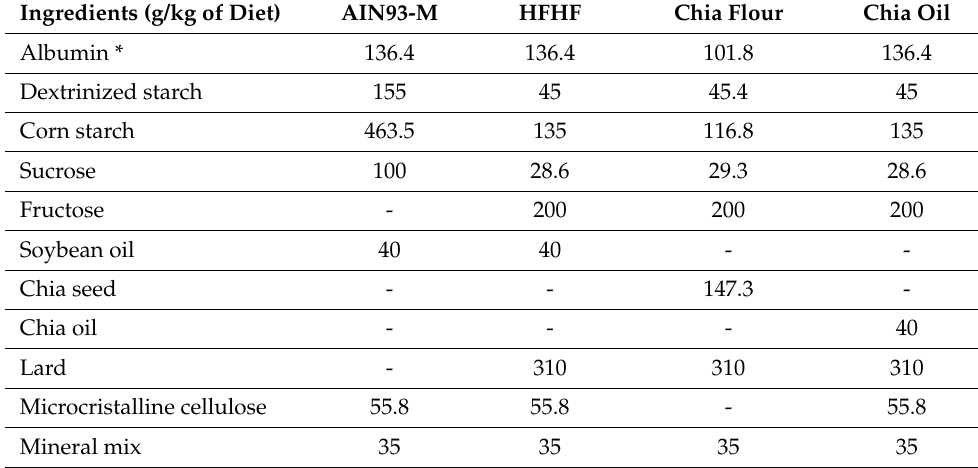
Figure 1. Experimental design. Phase I: Animals were fed a high-fat and high-fructose (HFHF) diet ( n = 30) containing 4% ( w / w ) soybean oil, 31% ( w / w ) lard and 20% fructose ( w / w ), or an AIN-93M diet ( n = 10) for eight weeks. In the chia treatments (phase II), the HFHF group was divided into three groups ( n = 10): HFHF diet: the animals kept the HFHF diet; chia flour (CF) treatment group: HFHF diet with 4% of soybean oil replaced by chia flour lipid (14.7% of chia flour); and chia oil (CO) treatment group: HFHF diet with 4% of soybean oil replaced by 4% of chia oil for ten weeks; and the AIN-93M group: the animals kept the AIN-93M diet for ten weeks. Table 1. Nutritional composition of experimental diets.